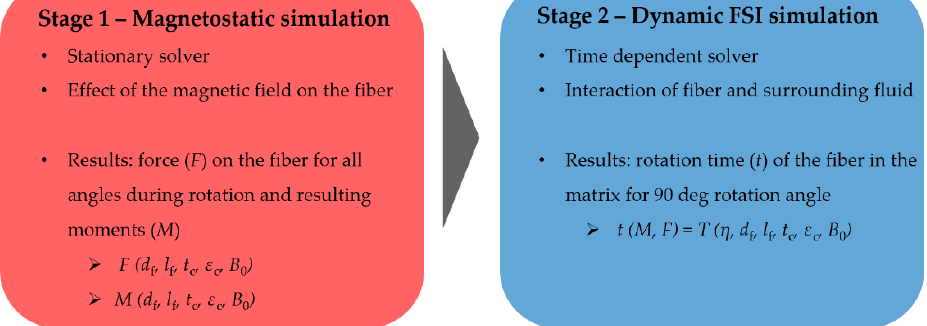
Figure 4. Reduction in the simulation model: ( a ) 3D model; ( b ) simplified 2D model.